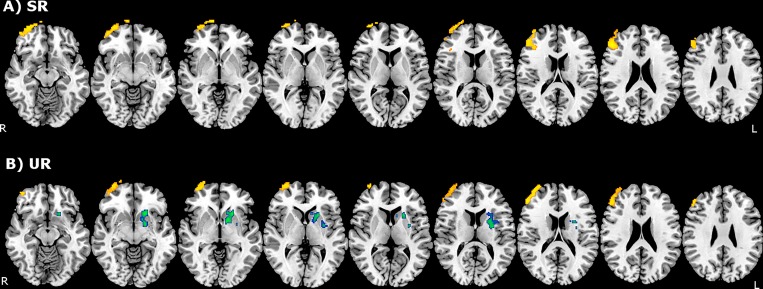
Between-group comparison showing probabilistic activation map after training.A) 'SR' condition. B) ‘UR' condition. Clusters in orange-yellow threshold indicate higher activations in adolescents. Clusters in blue-green threshold indicate higher activations in children. Images are shown in radiological orientation. SR–semantically related; UR–unrelated.